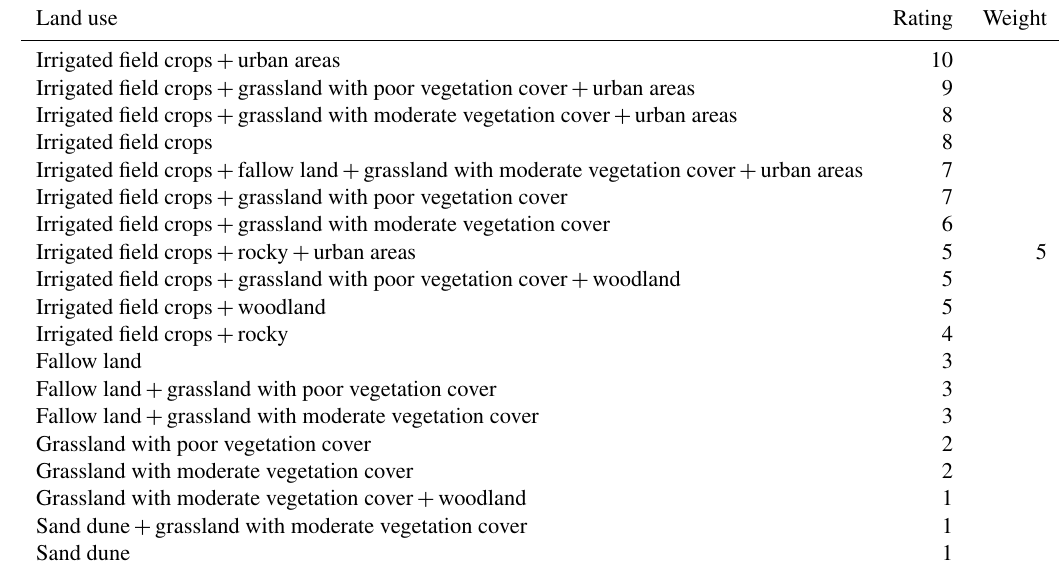
Table 4. Vulnerability ranges related to the CDRASTIC index. Vulnerability Ranges Very low 100 Low 100–145